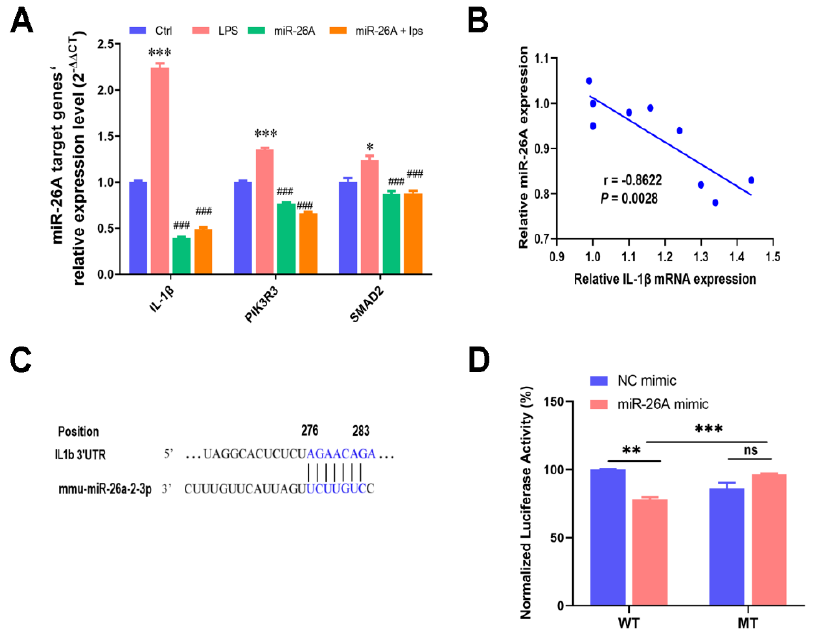
Figure 6. miR-26A targeting IL-1 β mRNA 3 ′ -UTR alleviated myotube inflammation. ( A ) qPCR validation of candidate target genes (IL-1 β , Pik3R3, Smad2) of miR-26A. ( B ) Correlation analysis of miR-26A with IL-1 β mRNA. ( C ) The binding region of miR-26A with the IL-1 β mRNA 3 ′ -UTR was predicted by Targetscan. ( D ) The dual luciferase assay verified the targeting relationship between miR-26A and IL-1 β in the 293T cells. The data shown are the means ± SEM, n = 3. * p < 0.05, ** p < 0.01, *** p < 0.001 vs. control cells, and ### p < 0.001 vs. LPS treated cells. Unmarked graphs show no significant difference.